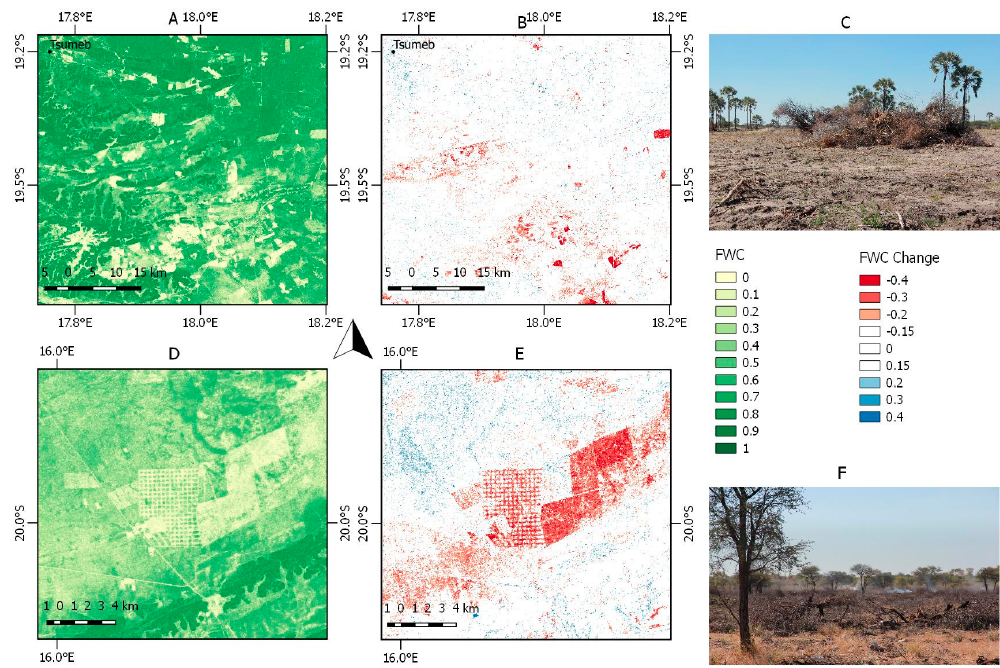
Figure 13. Examples of local patterns of fractional woody cover change maps (FWC Change, 50 m resolution). ( A ) Fractional woody cover of Tsumeb area in 2010 (FWC2010 50mSAR + MAP ) and ( B ) the corresponding FWC ∆ 2010–2009 showing distinct areas of debushing activities (FWC change > − 0.3). ( D ) FWC of area north of the town of Outjo in 2016 (FWC2016 50mSAR + MAP ) which experienced ( E ) significant changes in FWC since 2009 (FWC ∆ 2016–2009) due to debushing activities in a grid pattern. ( C , F ) Examples of mechanical debushing in the field.